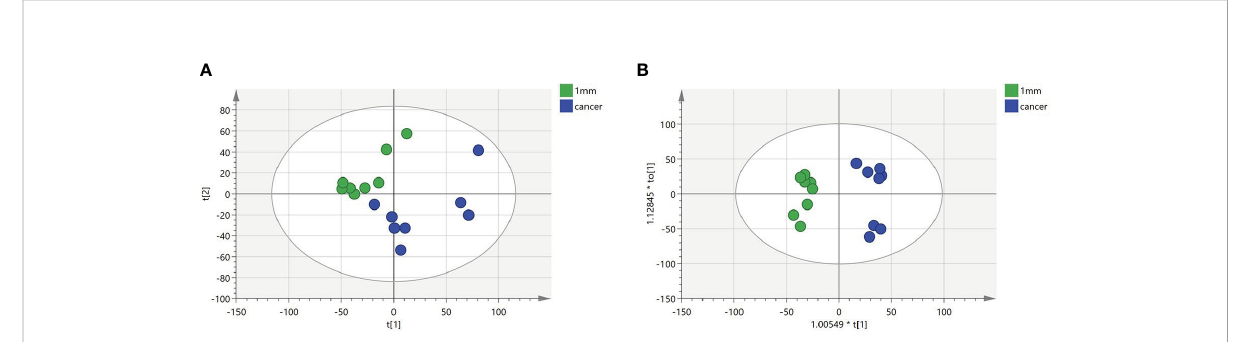
FIGURE 1 Multivariate statistical analysis of two groups. Principal component analysis (PCA) plot comparing between 1 mm cut edge tissue and cancer tissue in (A) negative ion mode; orthogonal partial least squares discriminant analysis (OPLS-DA) score plots comparing between 1 mm cut edge tissue and cancer tissue in (B) negative ion